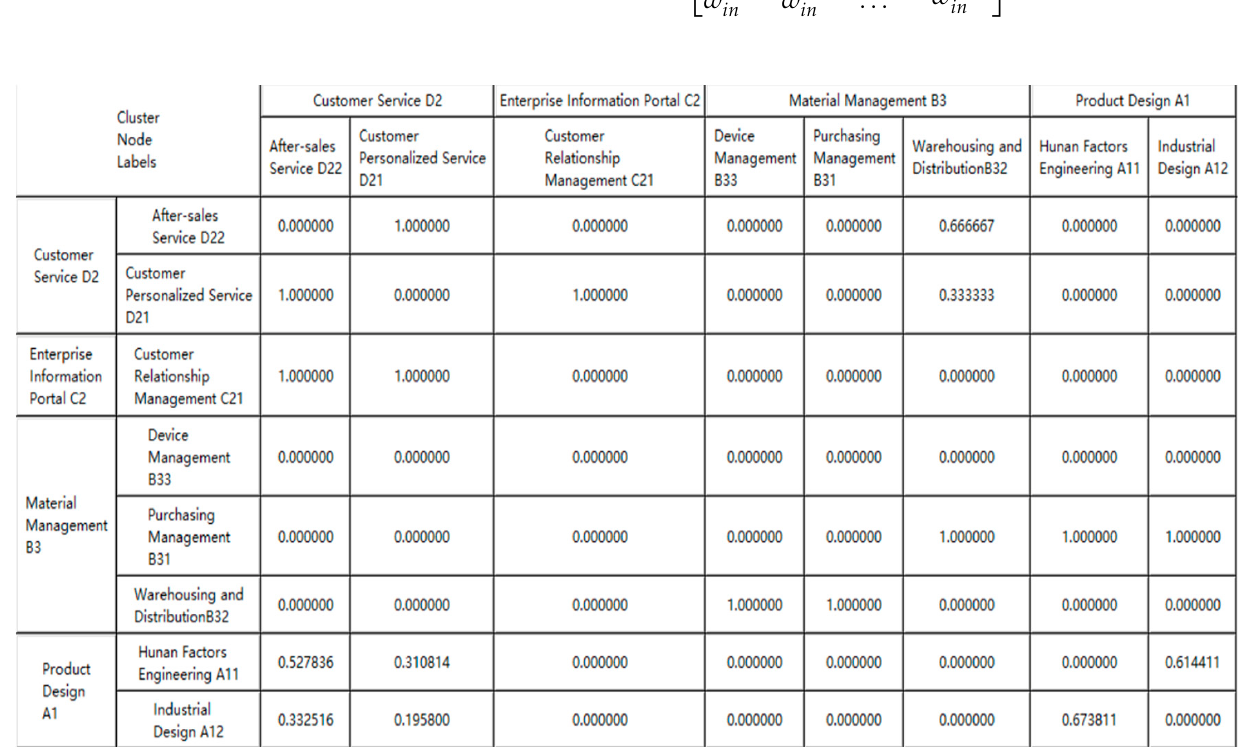
Figure 7. Unweighted hypermatrix (partial data) exported by SD software.